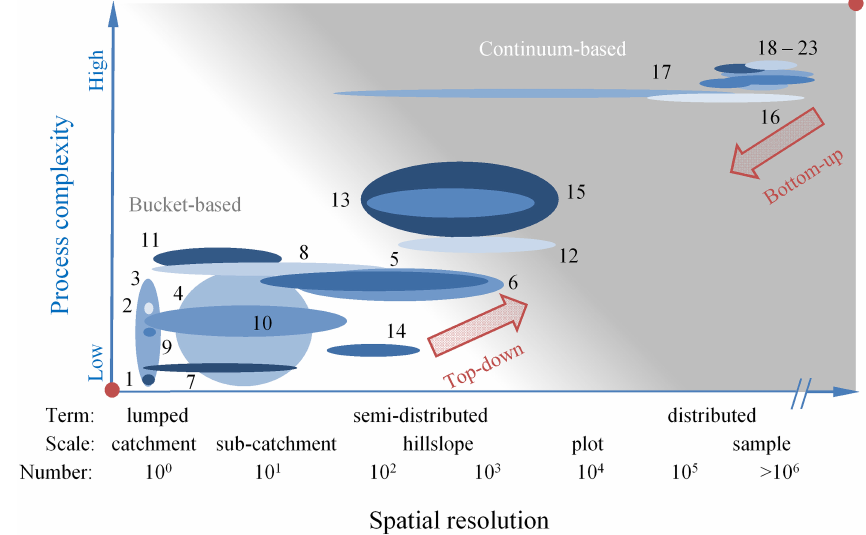
Figure 1. Conceptual sketch of approximate positions of a selection of typical applications of frequently used catchment-scale models on the spatial resolution–process complexity continuum. The spatial resolution axis shows approximate ranges of numbers and associated scales of individual spatial units (e.g. grid cells) within the model domain (e.g. catchment) for typical applications of the individual models. The process complexity axis indicates the number of individual processes/processes within one spatial unit. The increasingly grey shaded area indicates the transition from bucket-based (white) to continuum-based models. The red dots indicate the two endpoints along the resolution– complexity continuum. Models: 1: unit hydrograph (Sherman, 1932); 2: HBV (Bergström, 1992); 3: SUPERFLEX (Fenicia et al.,